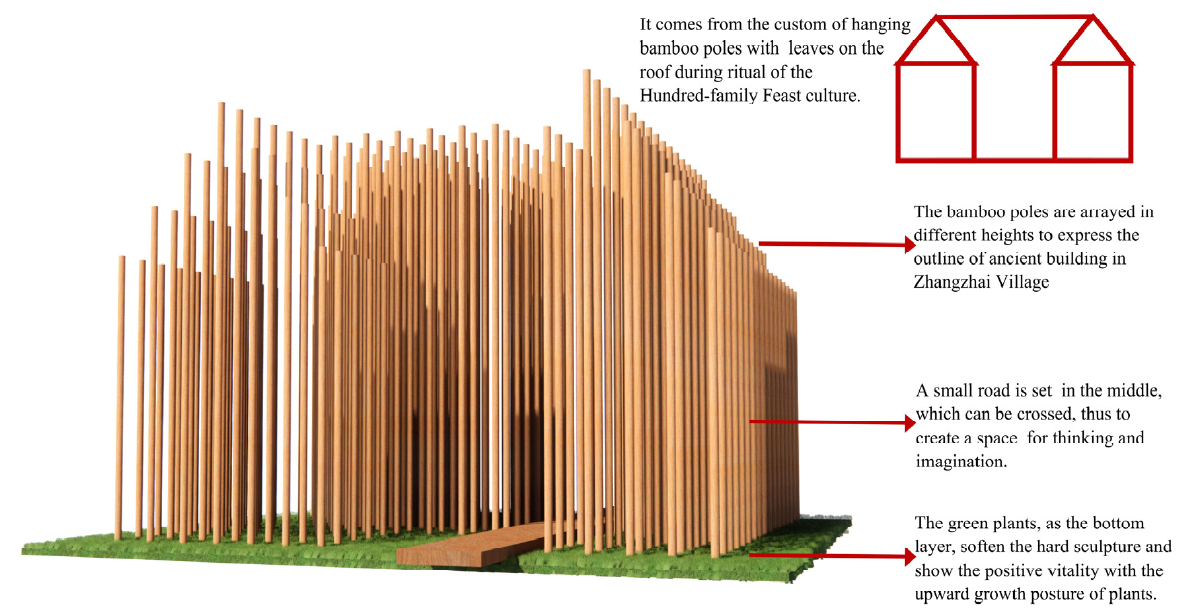
Figure 13. Ritual culture experience sculpture.